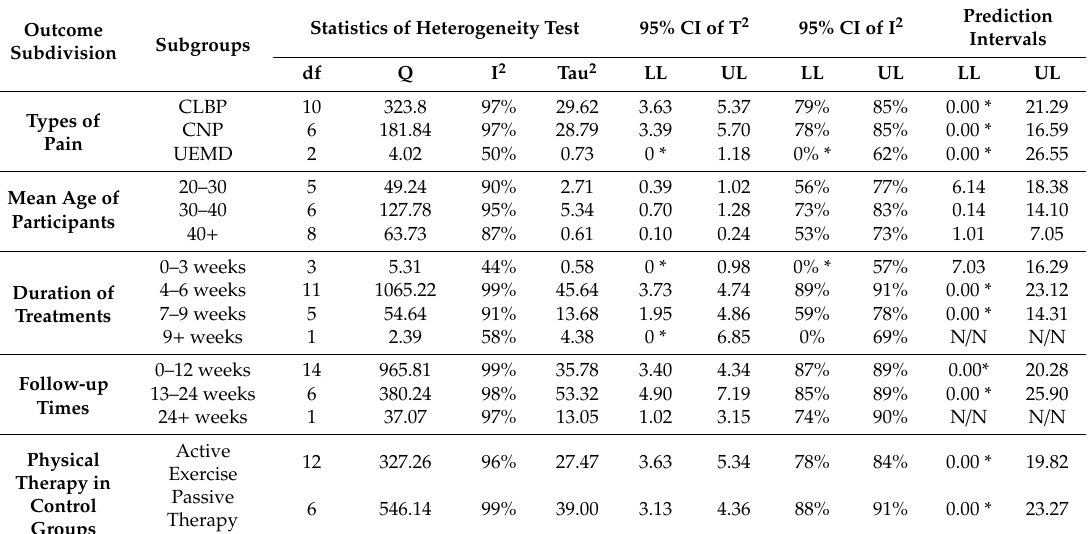
Table 5. The result of heterogeneity test of subgroup